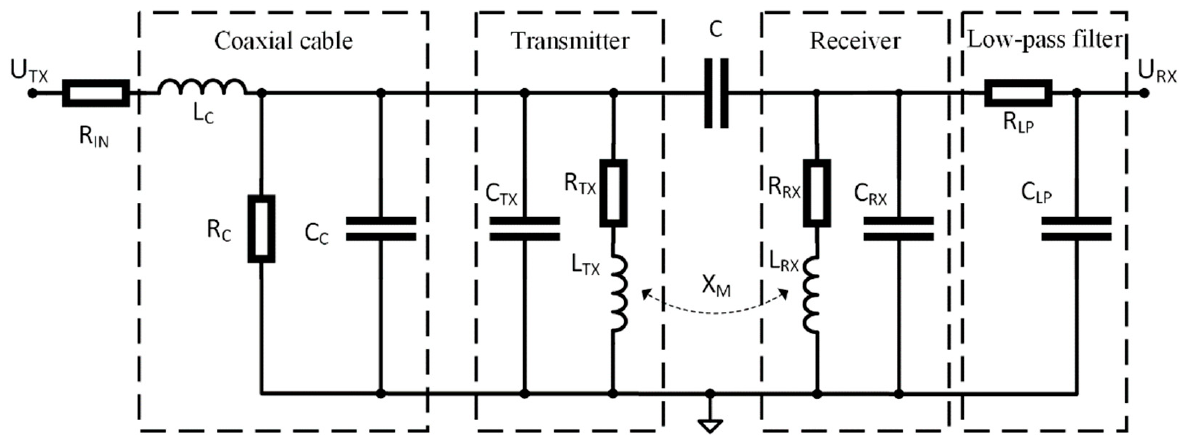
Figure 5. Equivalent circuit model of the experimental setup.